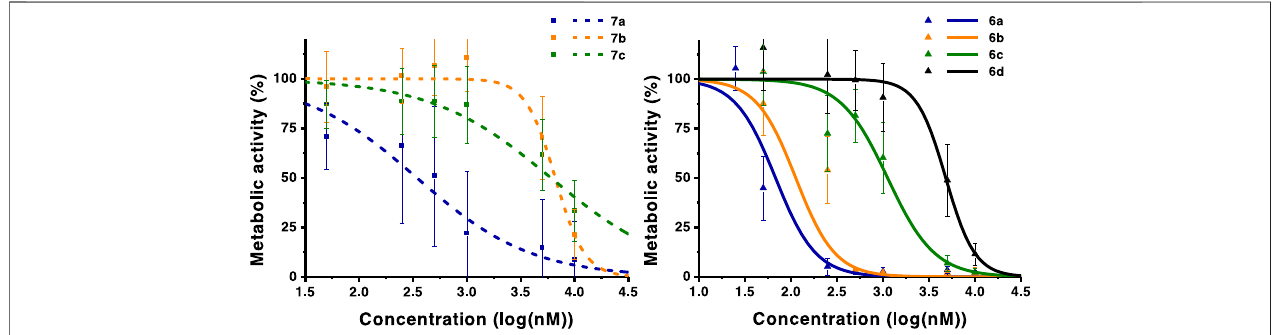
FIGURE 2 | Dose-response curves of A375 skin malignant melanoma cells. Analysis performed 24 h after PDT. The graph in the left includes monohydroxymethyl derivatives 7a – c . The graph in the right includes diacid chlorins 6 . Data points represent the mean ±SD.